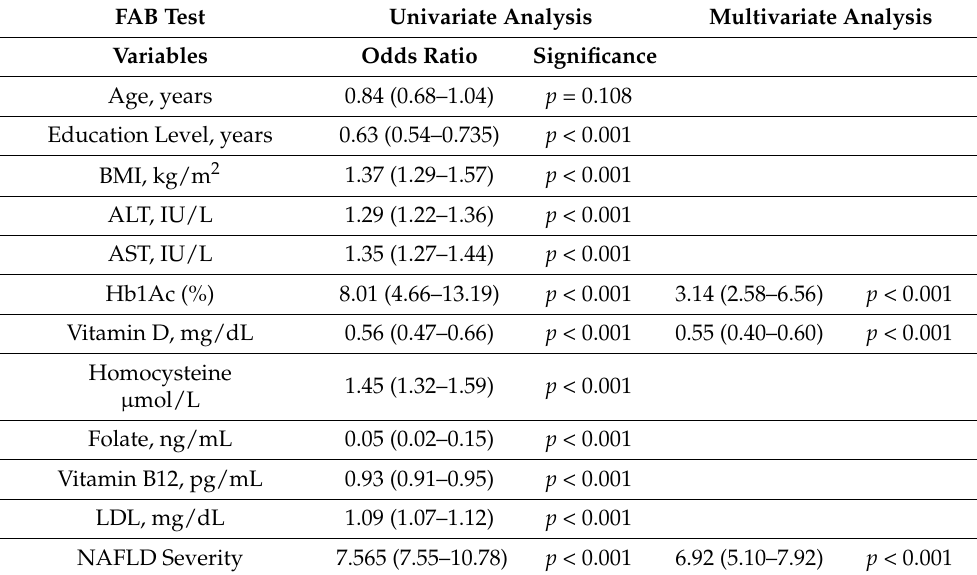
Table 4. Factors associated with worse FAB test results in terms of Odds Ratio and its 95% C.I. Variables are initially studied univariately and then multivariately by choosing the model with the lowest BIC. Abbreviations not previously explained: NAFLD—nonalcoholic fatty liver disease.